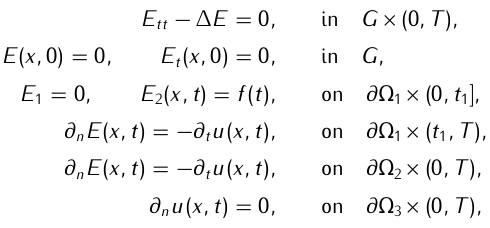
Figure 9. Test 1. Removal of spurious solutions on the finer mesh with the mesh size h electric field E h = ( E in the domain decomposition FEM/FDM in Ω ,E 1 h 2 h ) of the amplitude A in (46) is presented in Ω . Compare with Figure 8, where spurious modes appeared already at time T = 8 (there computations were performed on the coarser mesh with mesh size h = 0 . 125